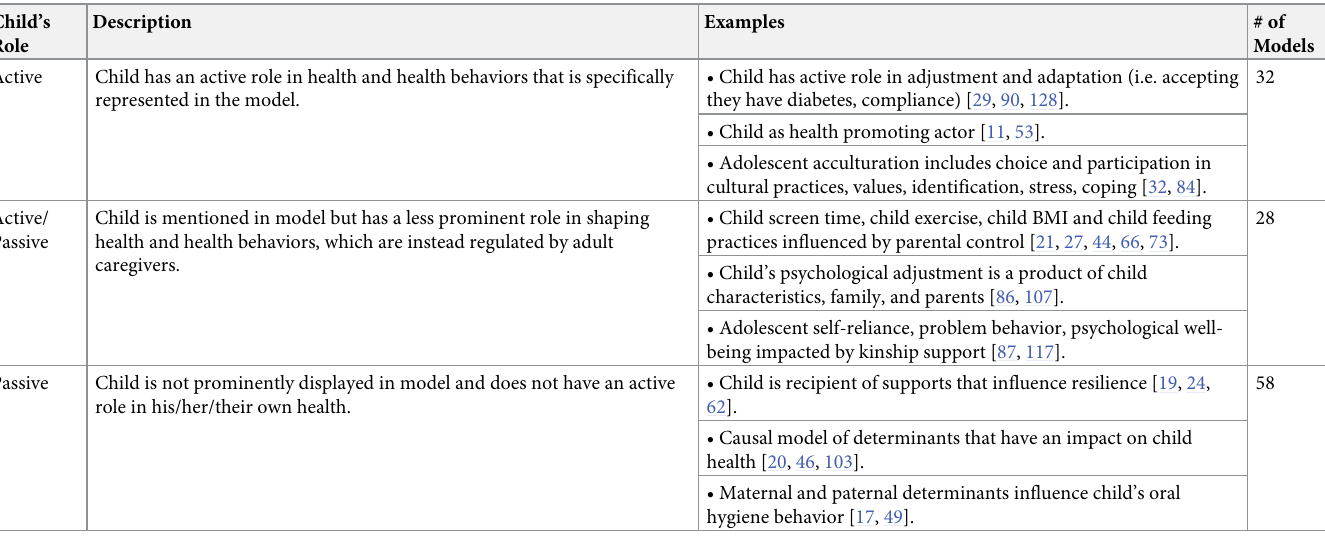
Table 6. Child’s role in shaping health